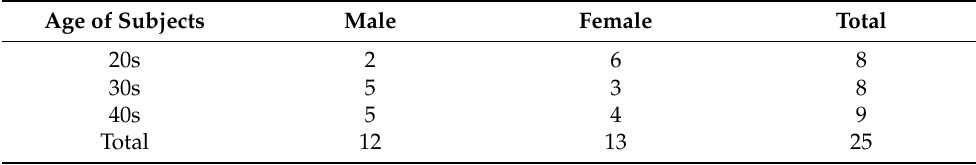
Table 1. Characteristics and age structure of subjects.